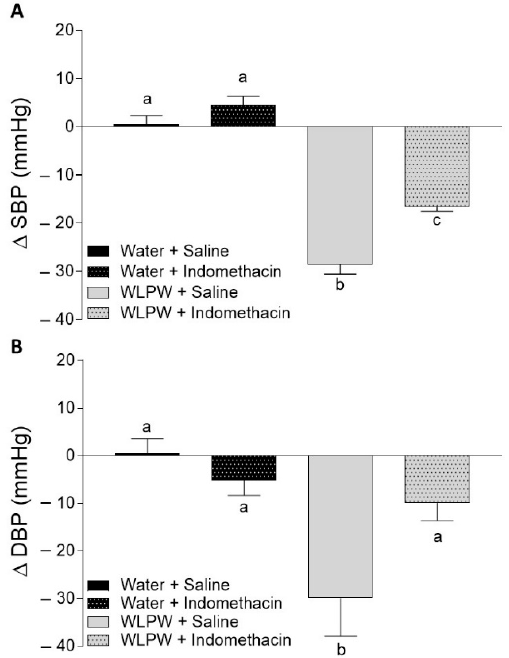
Figure 3. Changes in systolic blood pressure (SBP) ( A ) and diastolic blood pressure (DBP) ( B ) caused in spontaneously hypertensive rats 6 h post-administration by different treatments: oral administration of water or wine lees powder (WLPW) and intraperitoneal injection of Saline or Indomethacin. Significant differences ( p < 0.05) are represented by different letters and p was estimated by one-way ANOVA.